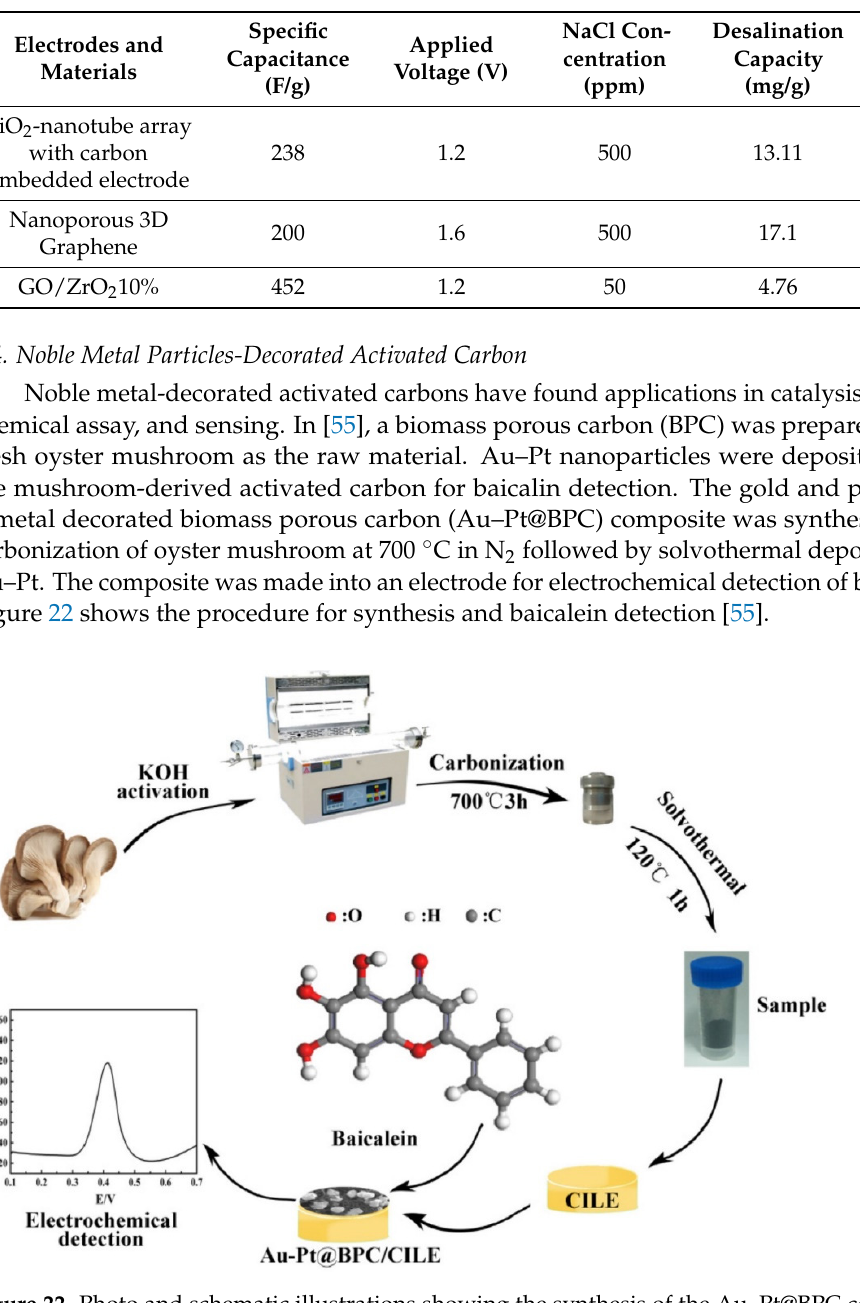
Figure 22. Photo and schematic illustrations showing the synthesis of the Au–Pt@BPC composite and the preparation of carbon ionic liquid electrode (CILE) for detecting baicalein. Reprinted with permission from [55], ©2020 Elsevier B.V.